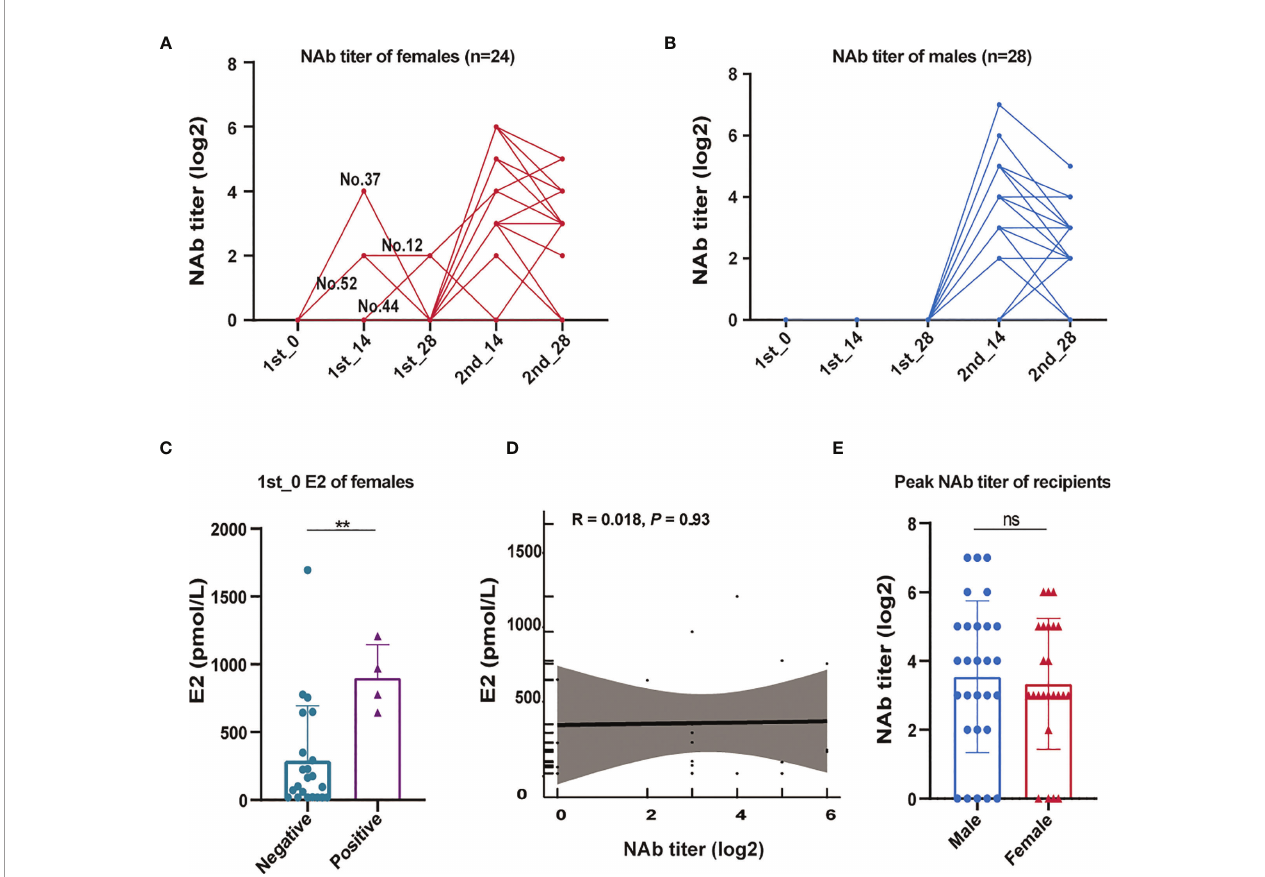
FIGURE 4 | The relationship between sex and NAbs expression. (A) Dynamic changes in anti-SARS-CoV-2 neutralizing antibodies in females (n=24). (B) Dynamic changes in anti-SARS-CoV-2 neutralizing antibodies in males (n=28). (C) Comparison of prevaccine E2 levels between females with or without seroconversion after the fi rst dose. (D) Correlation between the peak NAb titer and prevaccine E2 levels. (E) Comparison of peak NAb titers between males and females. A nonparametric Mann-Whitney U test was applied to analyze differences between the two groups. Correlations were analyzed by Pearson correlation coef fi cients. Statistical signi fi cance of the difference between groups is denoted as ** for P < 0.01. NAb, anti-SARS-CoV-2 neutralizing antibody; E2,